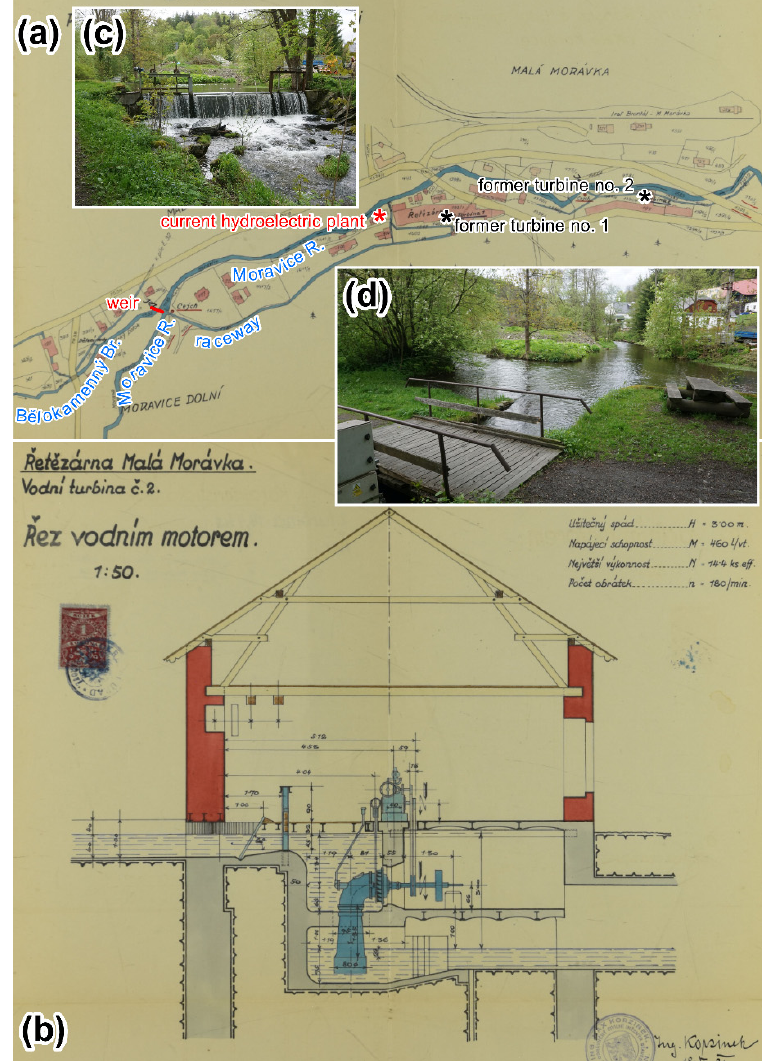
Figure 8. The Malá Morávka ironworks: ( a ) the historical layout from 1934, ( b ) a 1934 technical drawing of water turbine no. 2, ( c ) the weir right under the confluence of the Moravice river and the B ě lokamenný creek, ( d ) the confluence with the initial section of the raceway towards the hydropower plant (source: State District Archives in Bruntál, Rýma ř ov District Office).